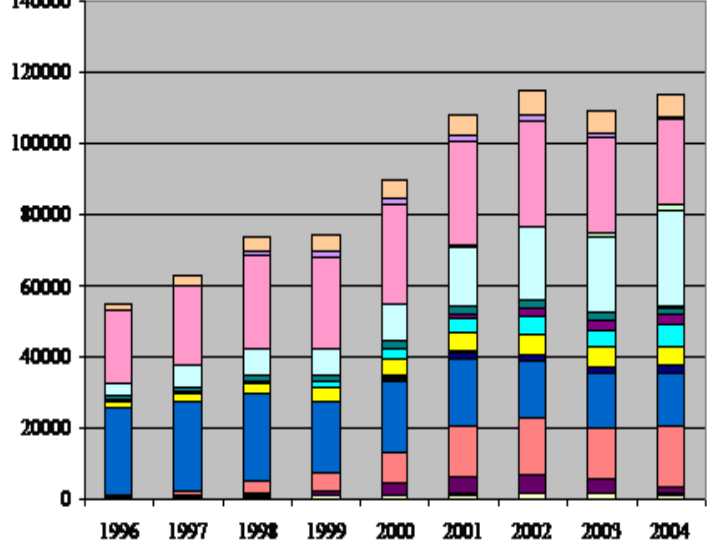
Figure 1. CQU Student Course Enrollment by Campus